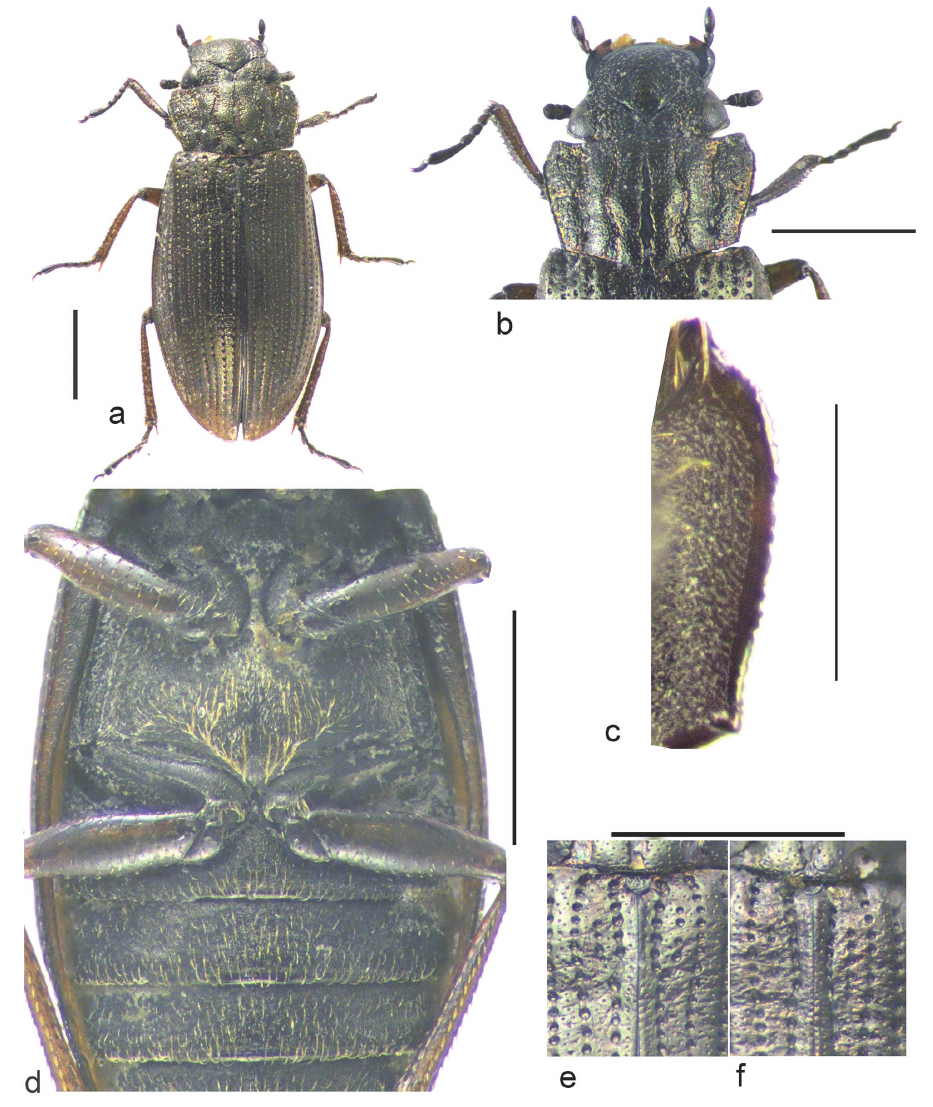
Figure 1. Helophorus dracomontanus sp. n. a holotype, dorsal b holotype head and pronotum, dorsal c paratype, lateral part of pronotum, ventral d paratype elytral epipleurs and flanks, metaventrite and abdomen, ventral e, f base of elytra and pronotum (dorsal) of holotype ( e ) and paratype ( f ) showing the scutellary striae. Scale bar: 1 mm ( a, b, d, e, f ); 0.5 mm ( c ).